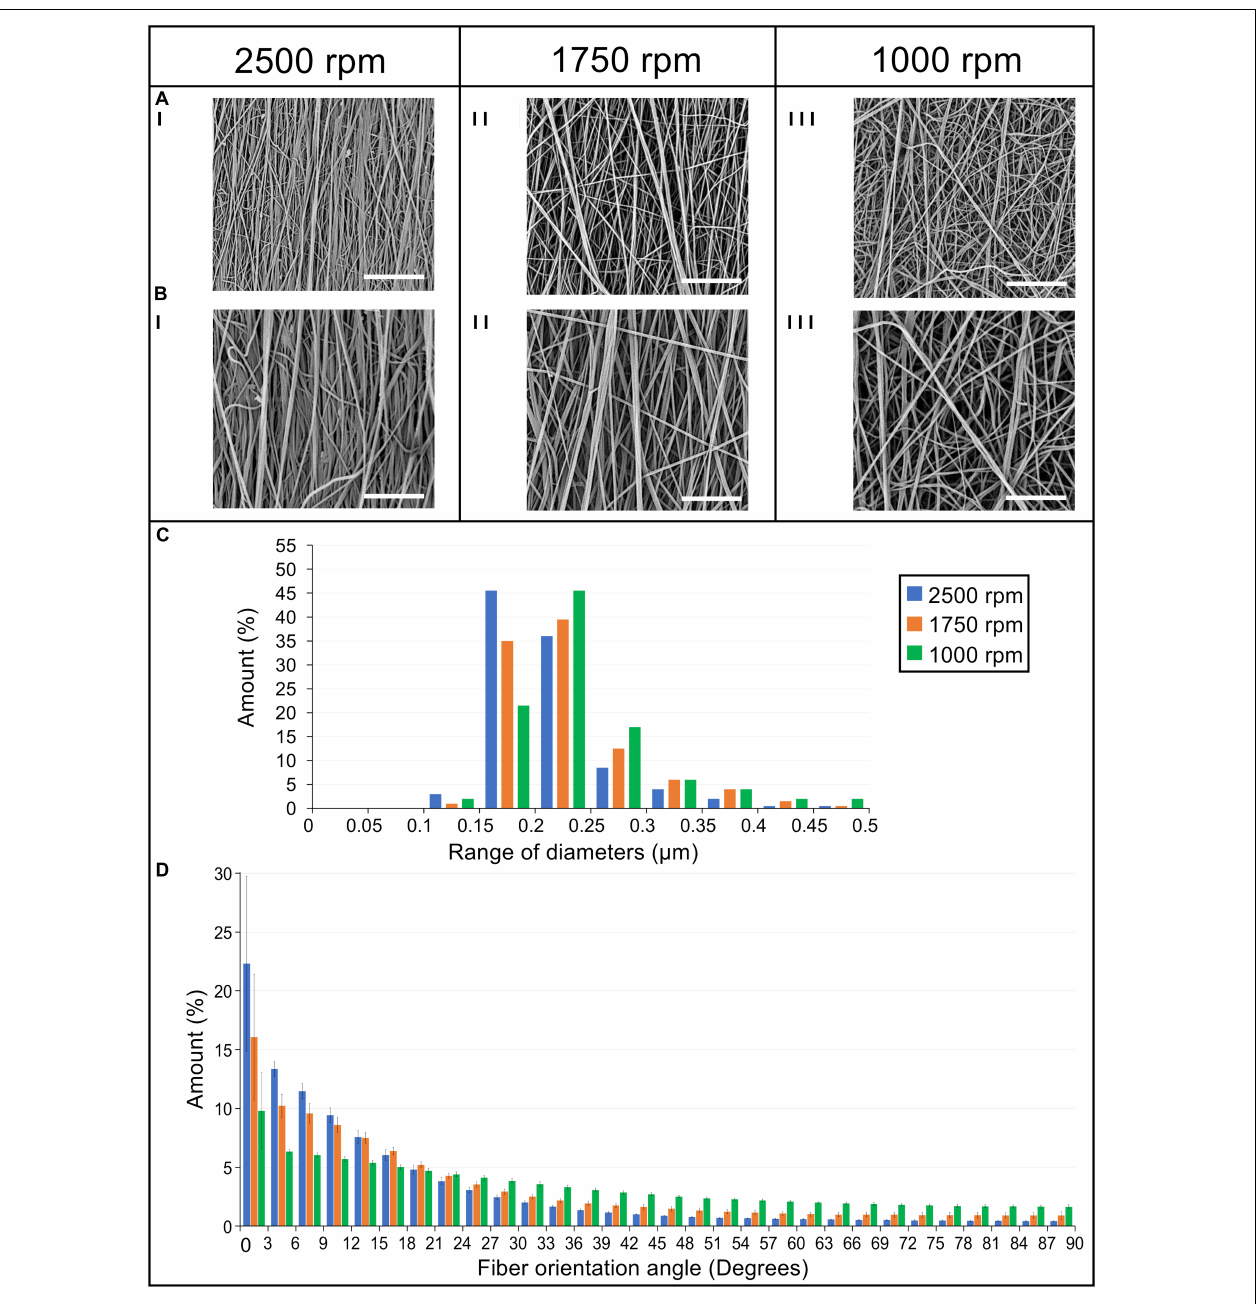
FIGURE 5 | Morphological investigation of the bundles nanofibers. SEM images of the nanofibers at (I) 2,500 rpm, (II) 1,750 rpm, and (III) 1,000 rpm acquired at different magnifications: (A) 8,000 × (scale bar = 10 µ m); (B) 15,000 × (scale bar = 5 µ m). (C) Diameter distribution of the nanofibers in terms of percentage for the different ranges of diameters for the 2,500 rpm (blue bars), 1,750 rpm (orange bars), and 1,000 rpm (green bars). (D) Orientation analysis of the nanofibers in which an angle of 0 ◦ corresponds to the longitudinal axis of the specimen while an angle of 90 ◦ corresponds to the circumferential direction. The directionality histograms show the distribution in terms of percentage (mean and standard deviation) of nanofibers for the different ranges of angles for the 2,500 rpm (blue bars), 1,750 rpm (orange bars), and 1,000 rpm (green bars).